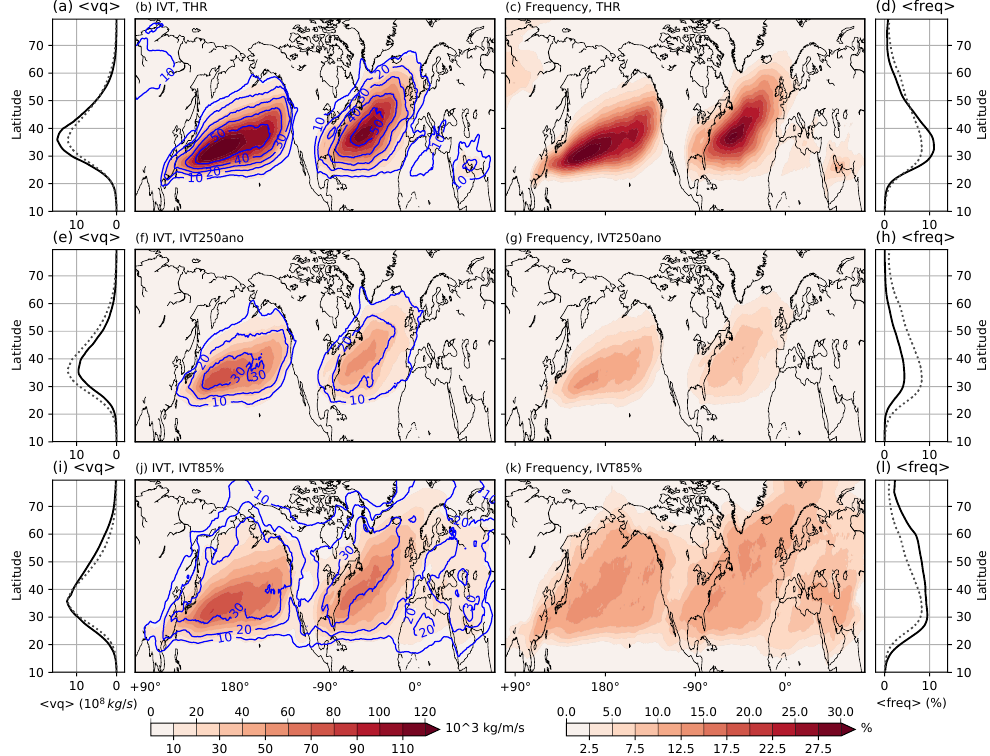
Figure 6. ( b , f , j ) show the IVT accumulations (in 10 3 kg/m/s) attributed to ARs detected by the THR (top row), the IVT250ano (mid row) and IVT85% (bottom row) methods. Solid blue contours show the percentage of AR-related IVT to the seasonal total. Contours are labelled with an interval of 10%. ( c , g , k ) are the average seasonal AR occurrence frequencies (%) of the three methods. Occurrence frequency is defined as the fraction of all time steps during the November–April season when a grid cell is included in an AR region. Left most column ( a , e , i ) shows as profiles the mean seasonal zonal averages of meridional fluxes (in 10 8 kg/s) by ARs detected by the three methods. And right column ( d , h , l ) shows the zonal average frequencies corresponding to the occurrence frequency distributions. Grey dotted curves in side profiles are the averages of the three methods. All data are averaged during the November–April seasons of November 2004 to April